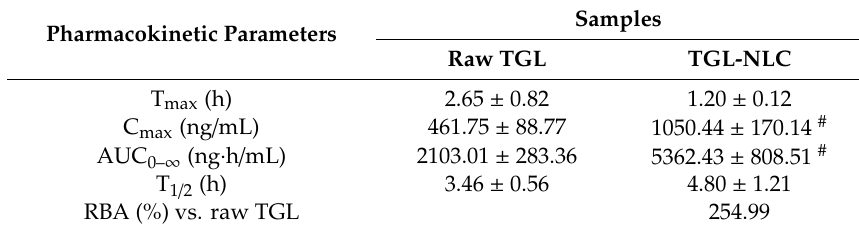
Figure 5. Plasma concentration-time curve of TGL in rats after single oral administration of raw TGL and TGL-NLC at a dose equivalent to 10 mg / kg of TGL. Data are expressed as the mean ± SD (n = 9). Table 5. Pharmacokinetic parameters after single oral administration of raw TGL and TGL-NLC in rats. Data are expressed as the mean ± SD (n = 9). # p < 0.05 vs. raw